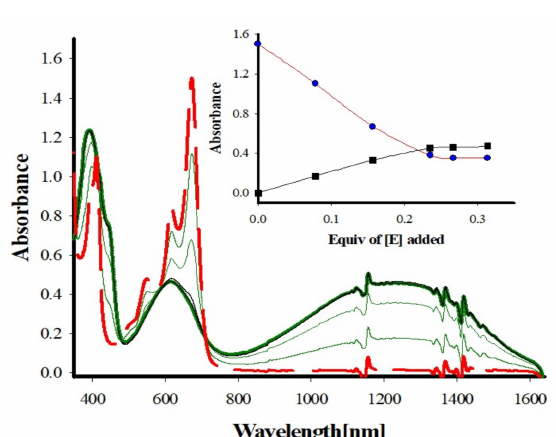
Figure 5. ( a , b ) The UV-vis-NIR absorption spectra of various calixarene ether mono-cation radicals calixarene ether tetra-cation radicals generated using either 4 equiv. of NAP + • in dichloromethane at 22 ◦ C.